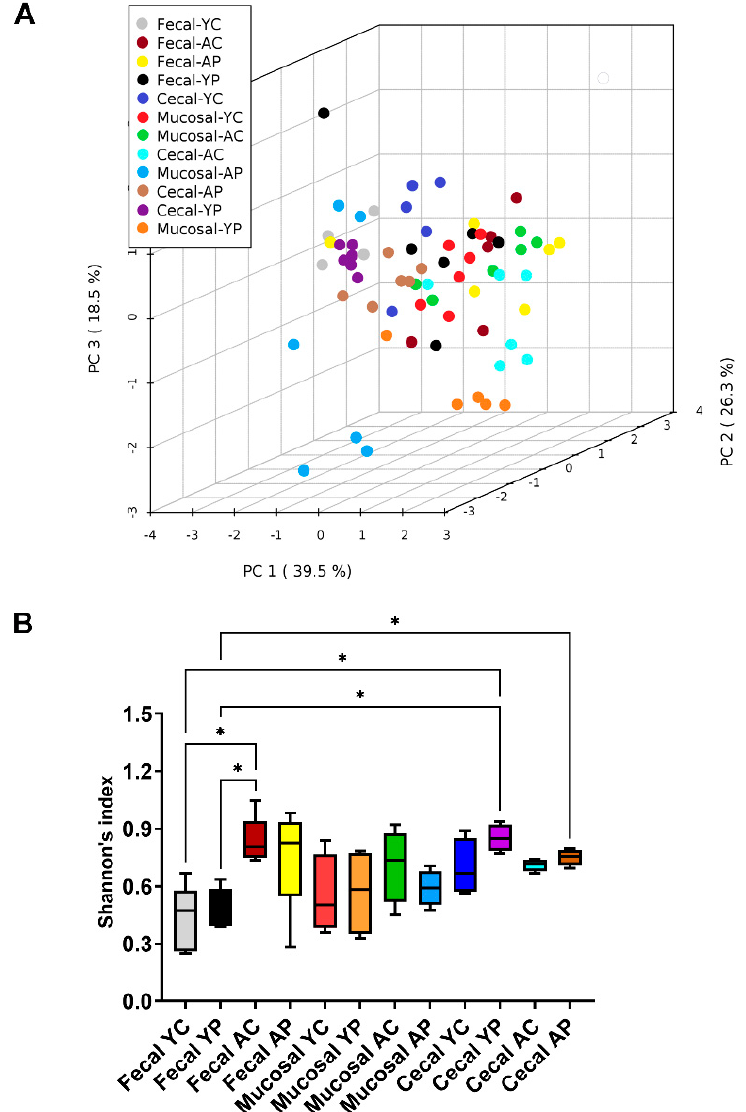
Figure 2. Fecal, mucosal, and cecal microbial diversity profiles in young and aging mice. ( A ) Principal coordinate analysis (PCoA) (unweighted UniFrac) showed divergence in fecal, mucosal, and cecal samples across ages (R 2 = 0.265; p < 0.001). ( B ) Boxplots of pairwise comparison showing no probiotic treatment-related differences in alpha diversity profiles between the samples by Shannon’s index. * Significant differences with p < 0.05. The values are shown as means ± SEM. (YC) Young control group, (YP) young probiotic group, (AC) aging control group, and (AP) aging probiotic group. The dominant phyla among all the groups were Firmicutes, Bacteroidetes, Verrucomi- crobia, and Proteobacteria (Figure 3A). The phylum-level LEfSe analysis with significant ( p < 0.05) phyla between groups is shown in Figure S1A. Significant increases in